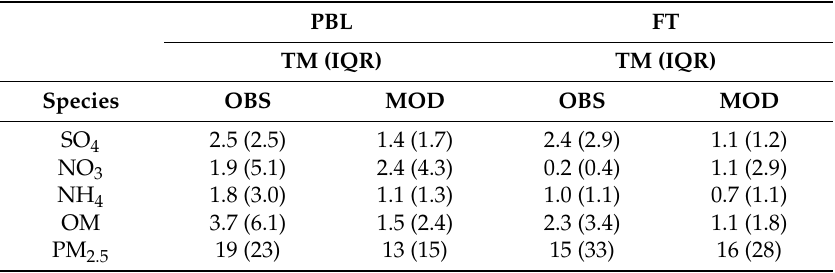
Table 5. Trimean (TM) values and interquantile range (IQR) of the aerosol mass concentration of SO 4 , NO 3 , NH 4 , OM, and PM 2.5 measured aboard the ATR-42 and simulated by WRF-CHIMERE. The values are calculated over the whole periods analysed in boundary layer (PBL) and free troposphere (FT). The units are in µ g/m 3 . PBL FT TM (IQR) TM